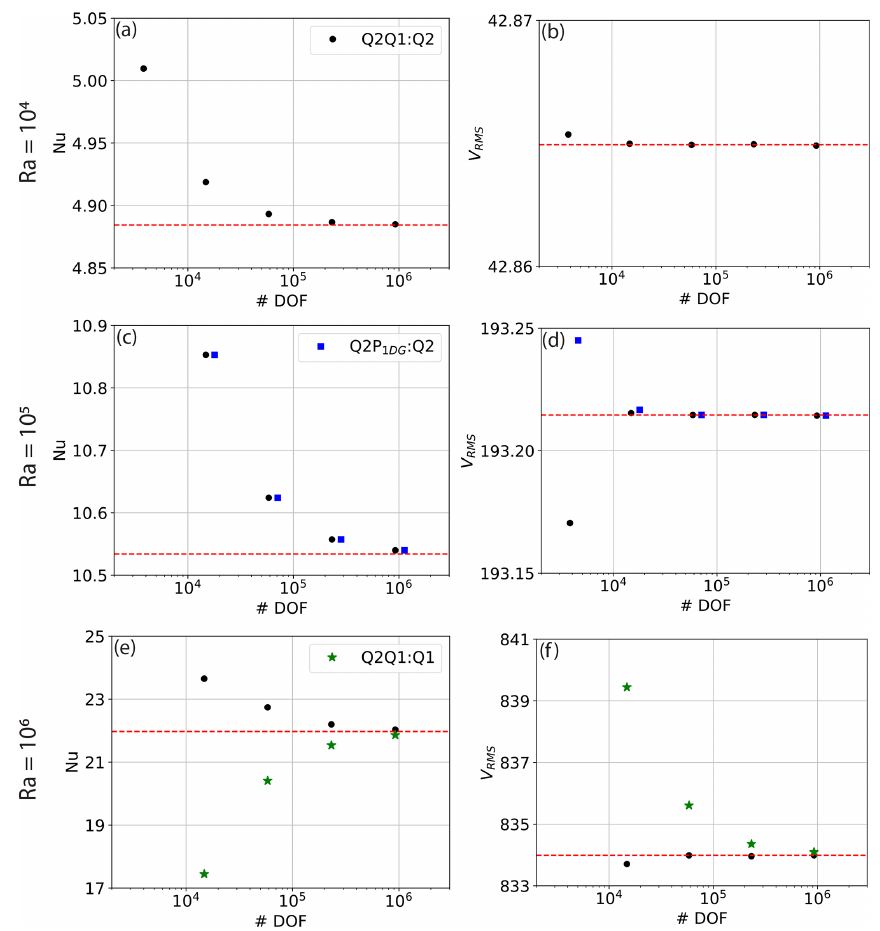
Figure 1. Results from 2-D incompressible isoviscous square convection benchmark cases: (a) Nusselt number vs. number of pressure and velocity degrees of freedom (DOFs) at Ra = 1 × 10 4 (Case 1a – Blankenbach et al., 1989) for a series of uniform, structured meshes; (b) rms velocity vs. number of pressure and velocity DOFs at Ra = 1 × 10 4 ; (c, d) as in panels (a) and (b) but at Ra = 1 × 10 5 (Case 1b – Blankenbach et al., 1989); (e, f) at Ra = 1 × 10 6 (Case 1c – Blankenbach et al., 1989). Benchmark values are denoted by dashed red lines. In panels (c) and (d) , we also display results from simulations where the Stokes system uses the Q2P 1DG finite-element pair (Q2P 1DG : Q 2) and in panels (e) and (f) , where temperature is represented using a Q1 discretisation (Q2Q1:Q1), for comparison to our standard Q2Q1:Q2